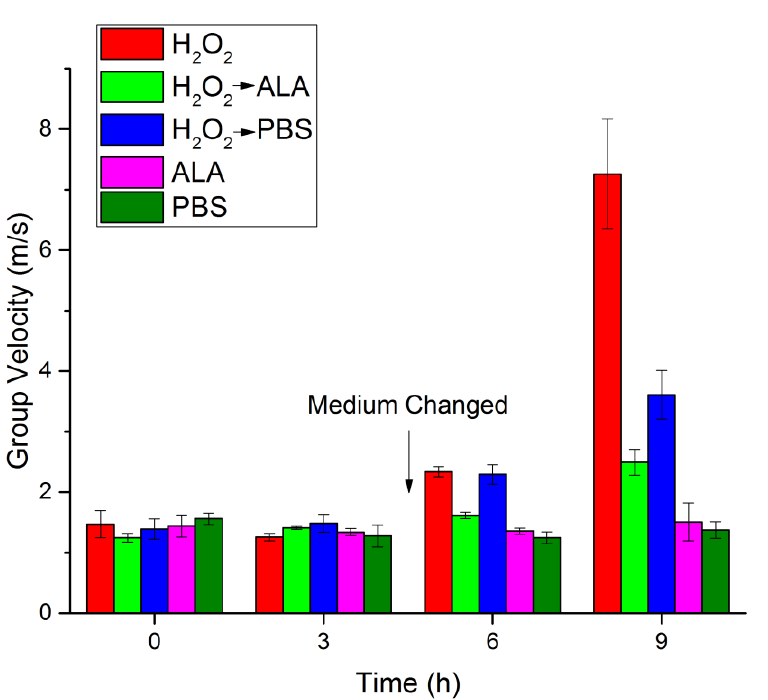
Figure 5. The surface wave group velocities measured in the lenses incubated with five different media. The data is presented at the inter-sample mean ± standard deviation (N = 3 for each group).